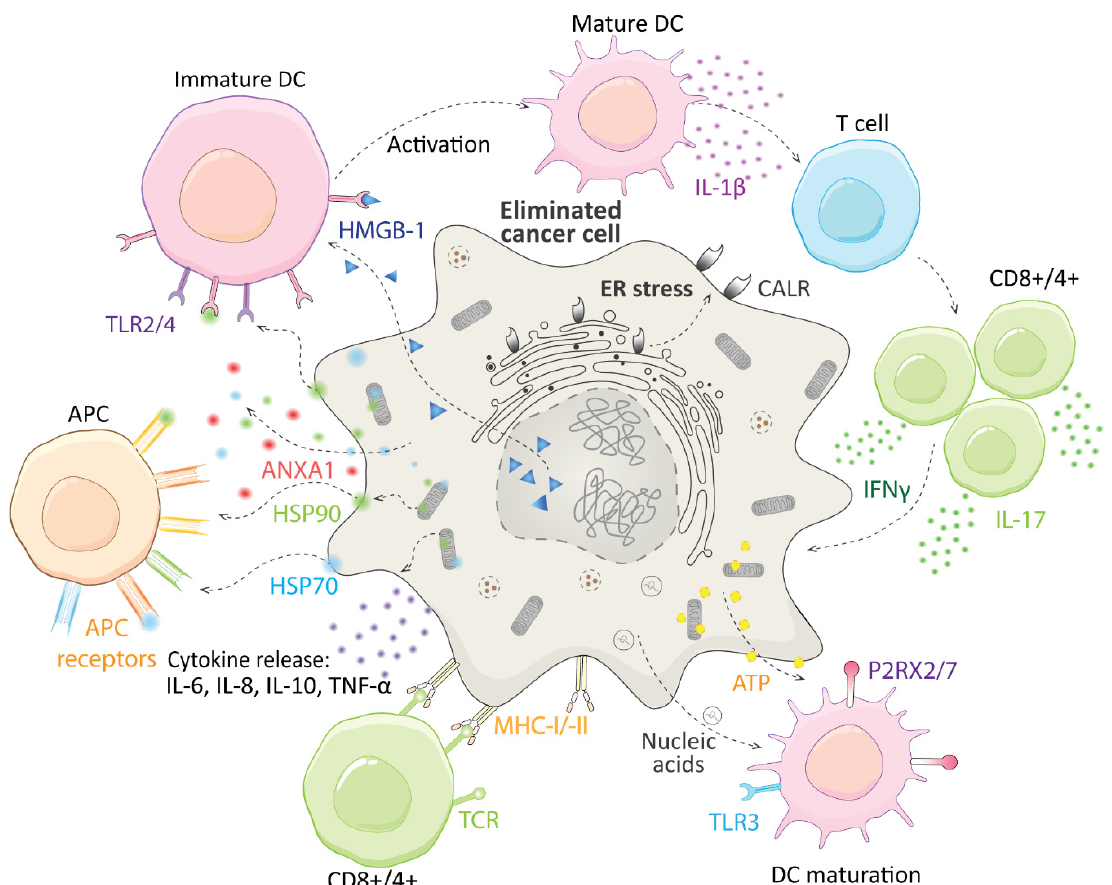
Figure 3. A schematic illustration of immunogenic cell death. The release of damage-associated molecular patterns (DAMPs), and activation of immune cells. ANXA1–annexin A1; APC–antigen-presenting cells; ATP–adenosine triphosphate; CALR–calreticulin; CD–a cluster of differentiation; DC –dendritic cells; ER–endoplasmic reticulum; HMGB-1–high mobility group box 1; HSP90/HSP70– heat shock protein 90/70; IFN γ –interferon γ ; IL-interleukin; MHC I/-II–major histocompatibility complex I/II; TLR–Toll-like receptor; P2RX2/7-P2X purinoceptor 2/7; TNF α –tumor necrosis factor α .